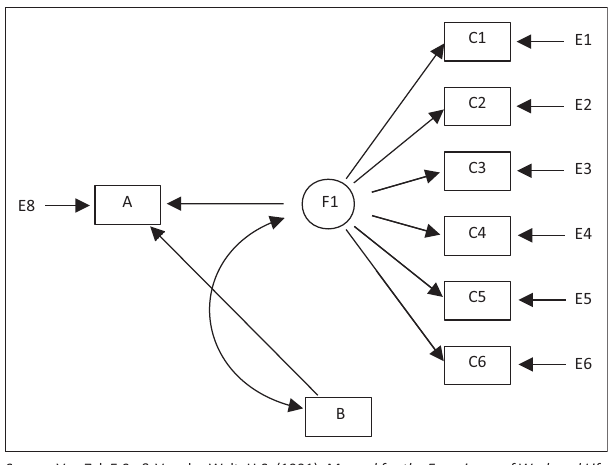
FIGURE 1: Hypothesised higher-order structural model of the Experience of Work and Life Circumstances